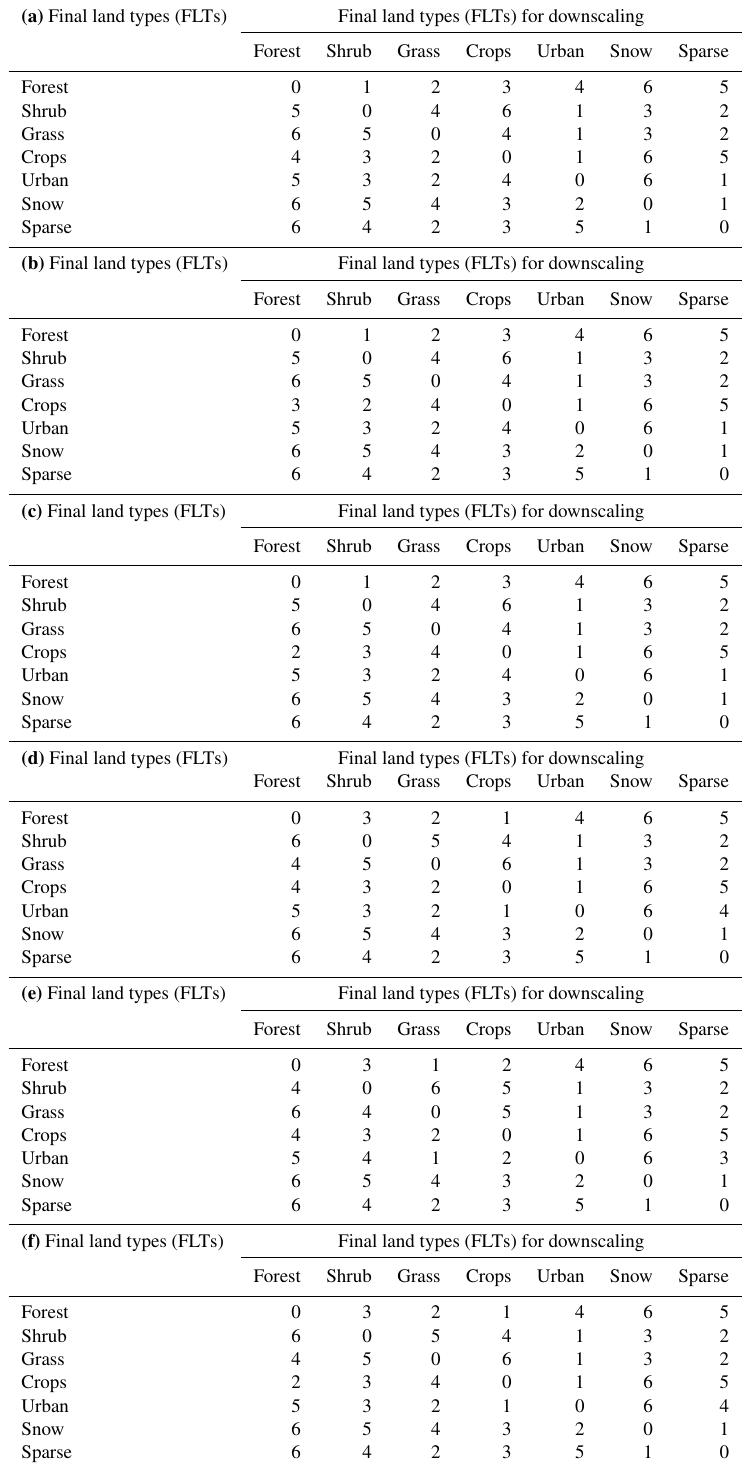
Table 9. Configurations of the final land types (FLTs) transition priorities for the sensitivity